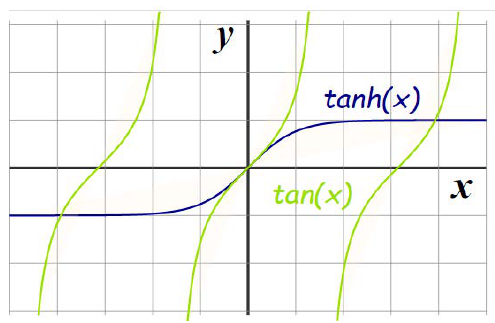
Fig. 2 Tanh-function expanded